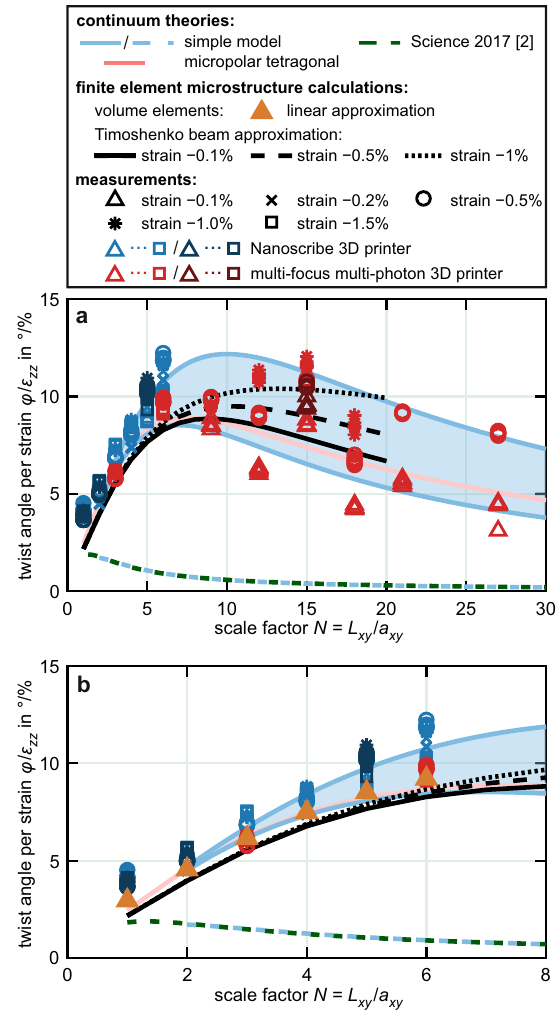
Fig. 5 Summary of the numerical and experimental results of the twist per axial strain. a A metamaterial composed of unit cells as shown in Fig. 1 is subject to an axial compressive strain (cf. Fig. 3a). The resulting twist angle per axial strain, φ ( N )/ ϵ zz , is plotted versus N . For the chosen lattice constants and chosen fi xed sample height-to-width aspect ratio of A = 2, the resulting total number of metamaterial unit cells is given by N x N y N z = 3 N 3 . In the experiments, the stacking of a left-handed and a right-handed sample part leads to a total number of N x N y N z = 2×3 N 3 . Five types of results are summarized: experiments, microstructure calculations using beam elements (the three black curves are the same as in Fig. 3b for d T / a xy = 4.4%), micropolar Eringen elasticity computations, and the simple analytical model. For experiment and microstructure calculations, results for different strain values are depicted (see symbols and legend). Dark-red (dark-blue) and light- red (light-blue) symbols at a given N correspond to experiments on different samples. Different measurements on the same sample are also shown. Eringen elasticity and the simple model are within the linear-elastic limit. For the simple model, we depict a range of curves corresponding to fi xed φ (1)/ ϵ zz = 2.4°/% and varying N c from 7 to 10, for the tetragonal case as considered here. For the case of ref. 2 , we fi t φ (1)/ ϵ zz = 2.0 and N c = 1.7. b Same as a , plus microstructure calculations using volume elements and for a smaller range of N to improve the visibility of the large number of data points at small N . data go up to N = 27. We note that the magnitude and the sign of the geometrical nonlinearities are generally different for com- pressive or tensile axial strain, respectively 6 . The experiments reported here are restricted to compressive strain ϵ zz < 0. COMMUNICATIONS MATERIALS| (2021) 2:4